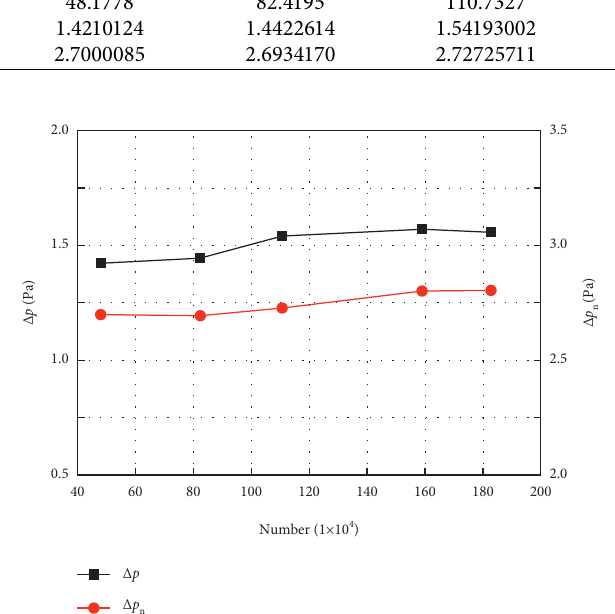
Figure 8: Grid independence verification